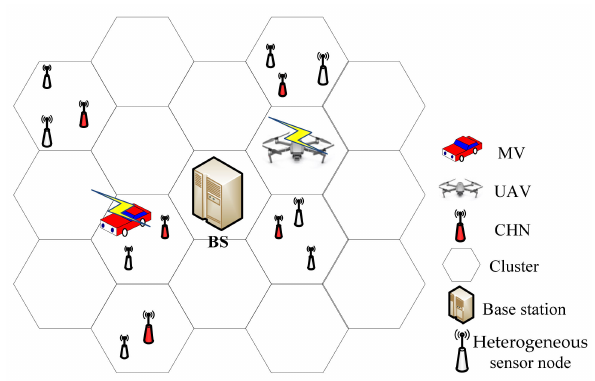
Figure 2. Diagram of our